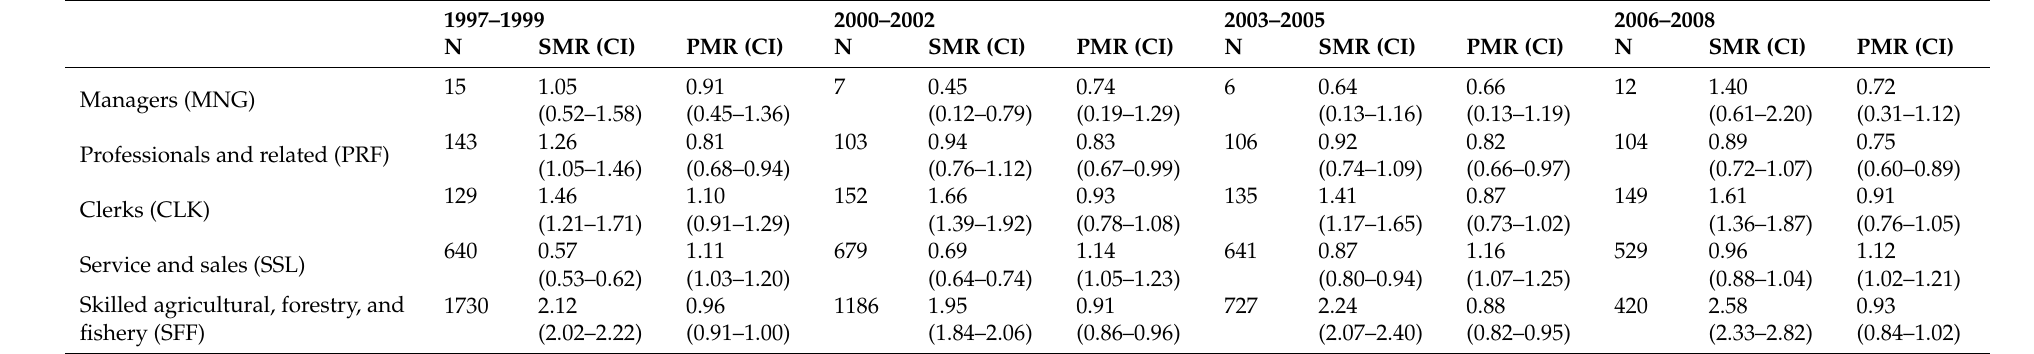
Table 4. SMR and PMR of female CCVD death by occupation, every 3